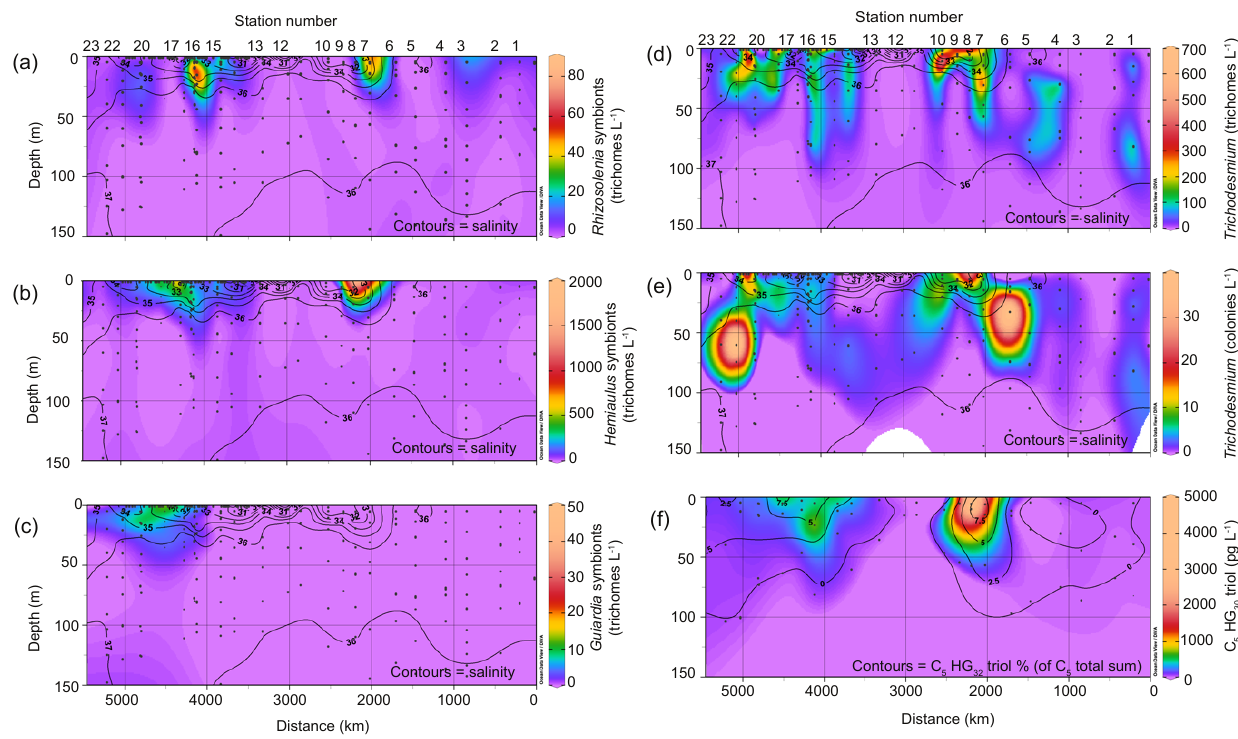
Figure 4. Diazotroph abundance along the cruise track. Color scales show (a) Rhizosolenia symbionts (trichomes L − 1 ), (b) Hemiaulus symbionts (trichomes L − 1 ), (c) Guinardia symbionts (trichomes L − 1 ), (d) Trichodesmium (free trichomes L − 1 ) and (e) Trichodesmium (colonies L − 1 ), while contour lines show salinity (a–e) . (f) Color scale shows concentration of C 5 HG 30 triol (pgL − 1 ) while contour lines show C 5 HG 32 triol % (of C 5 total sum). Station numbers noted above plots, distance along transect from the Cabo Verde islands below. Dots in (a–c) indicate sampling depth for the salinity contours. Dots in (a–e) indicate sampling depth for the salinity contours. Dots in (f) indicate sampling depth for HG